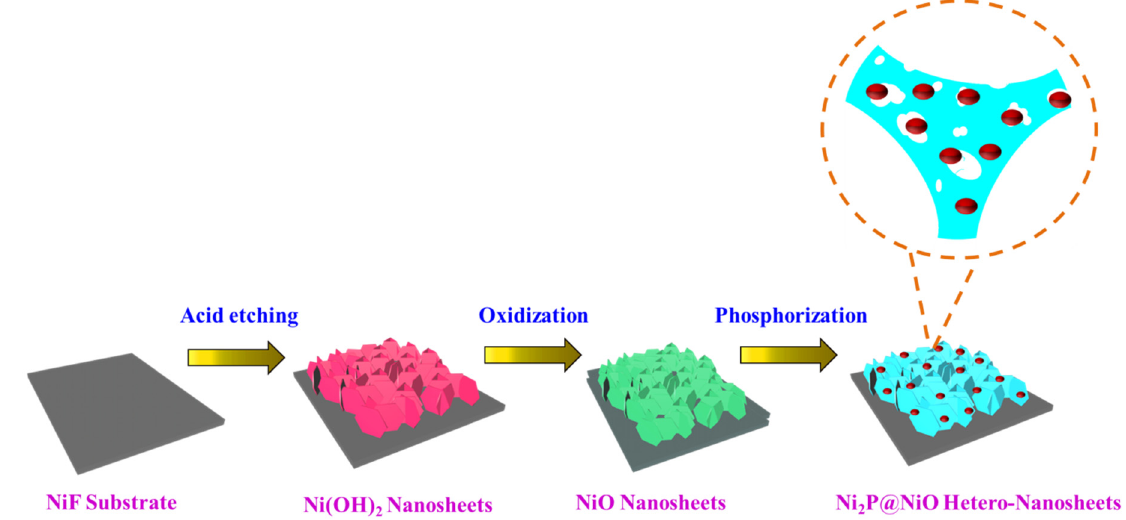
Scheme 1. Pictorial representation showing the growth of porous hetero-structured Ni 2 P@NiO nanosheets on the surface of NiF substrate.